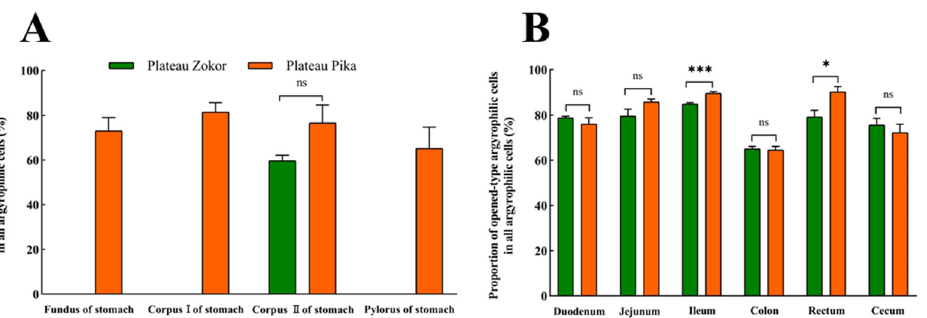
Figure 3. The difference in the proportion of opened-type argyrophilic cells in the gastrointestinal organs of the plateau zokor and plateau pika. ( A ) The difference in the proportion of opened-type argyrophilic cells in the stomach; ( B ) the difference in the proportion of opened-type argyrophilic cells in the intestinal tract. * and *** indicate significant interspecific difference ( p < 0.05, p < 0.001); ns indicates an insignificant interspecific difference.